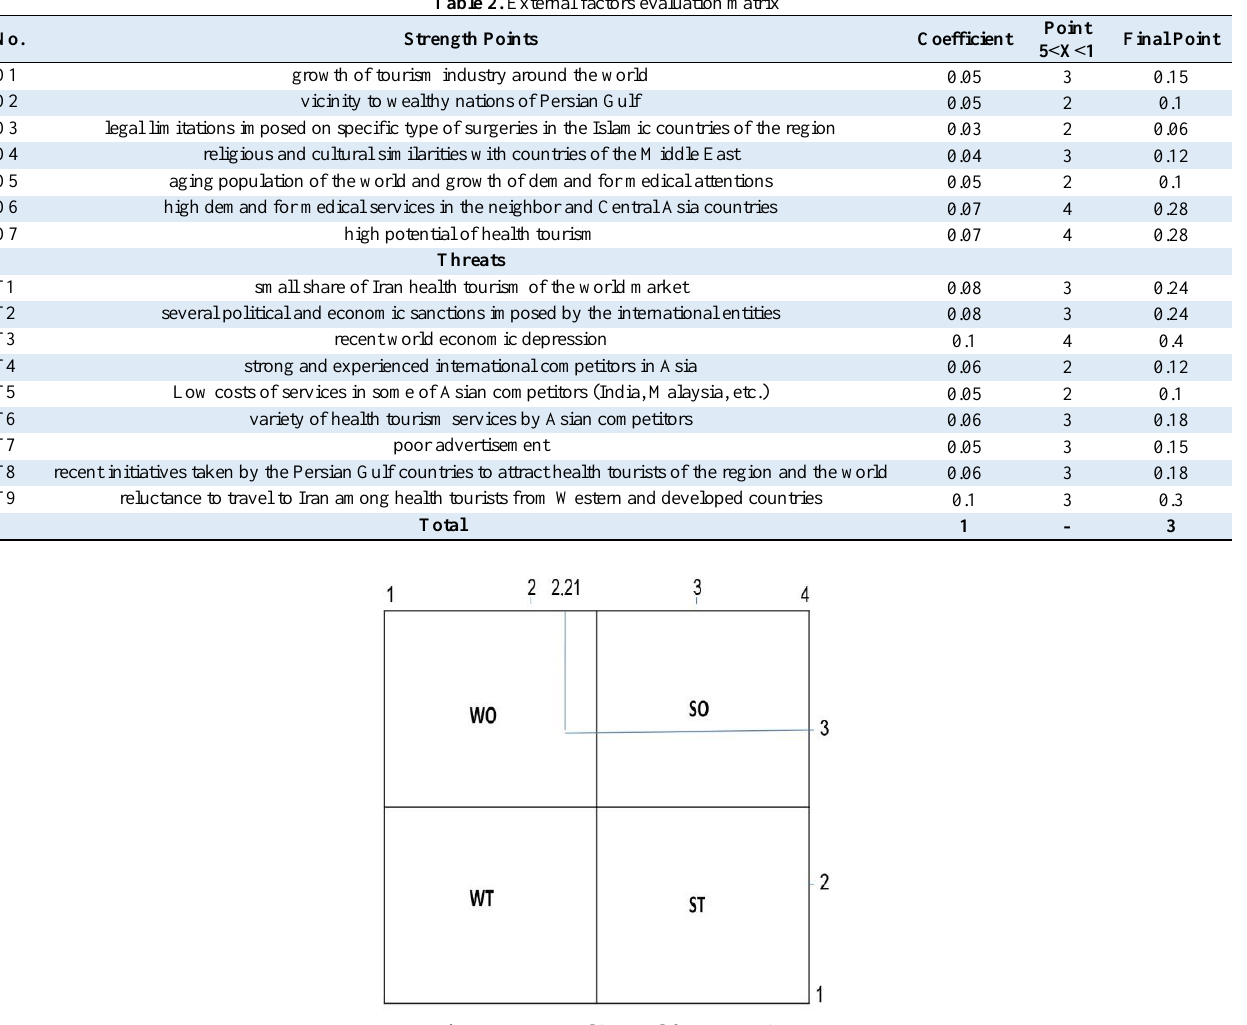
Table 2. External factors evaluation matrix